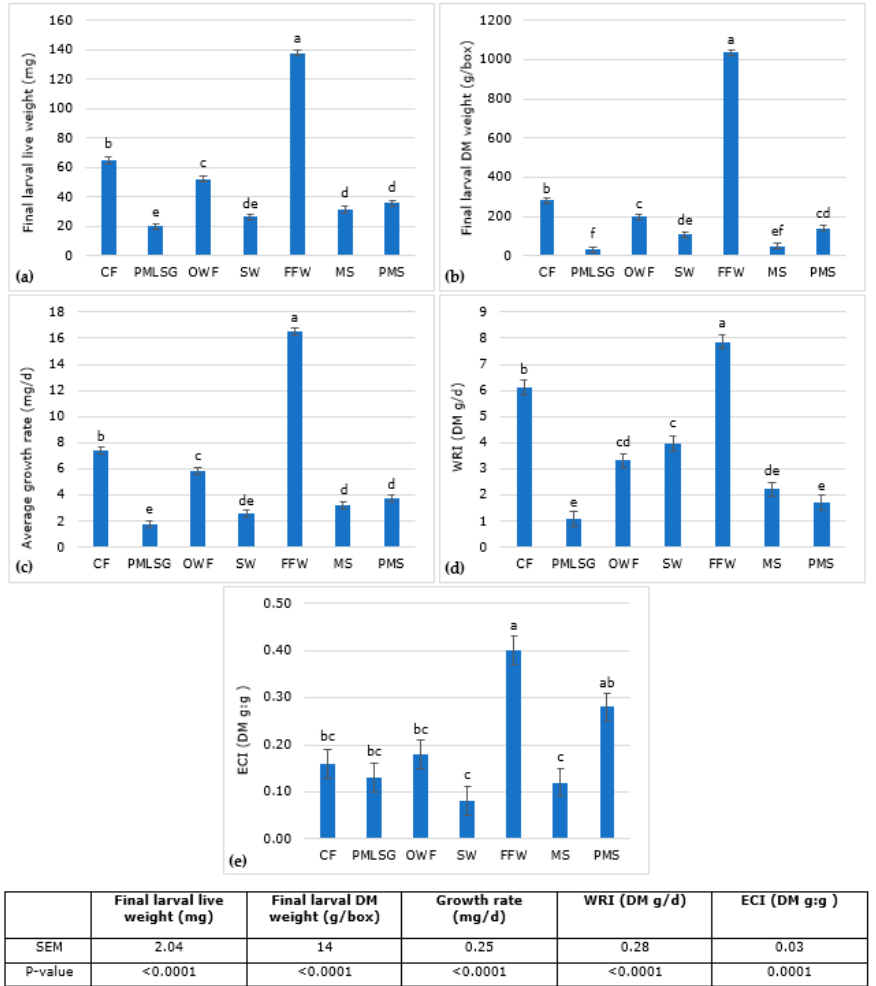
Figure 1. The mean values ± SEM of the final fresh ( a ) and dry ( b ) weights (mg), growth rate (mg/d) ( c ), waste reduction index (DM g/d) ( d ) and efficiency of conversion of the ingested substrate (DM g:g) ( e ) of BSFL grown on different substrates 1 . Means with different superscript letters differ significantly (two-way ANOVA followed by Tukey’s post hoc test analysis p < 0.05). Chicken feed (CF; control diet), pig manure slurry mixed with roadside silage grass (PMLSG), organic wet fraction (OWF), slaughter waste (SW), fast food waste (FFW), mushroom stems (MS) and pig manure solid